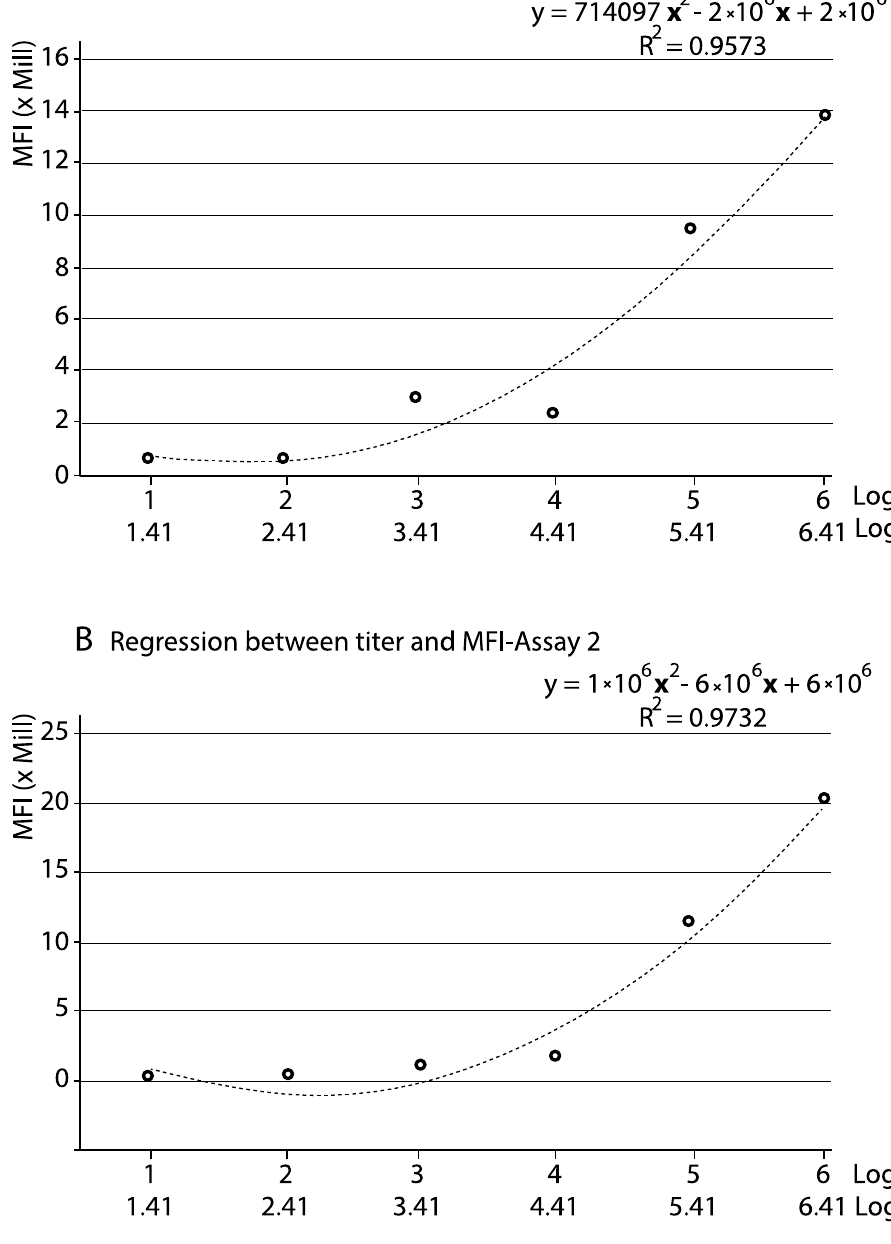
Figure 3. Reliability of qFCM for viral titration. Second degree polynomial regression between the viral titre (in pfu and TCID 50 ) and fluorescence (in MFI). Each data corresponds to a single data point.